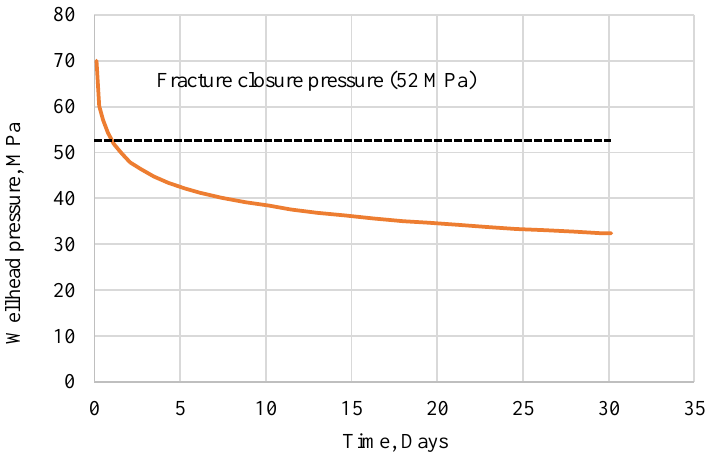
Figure 12—Wellhead pressure curve in the traditional flowback scheme.